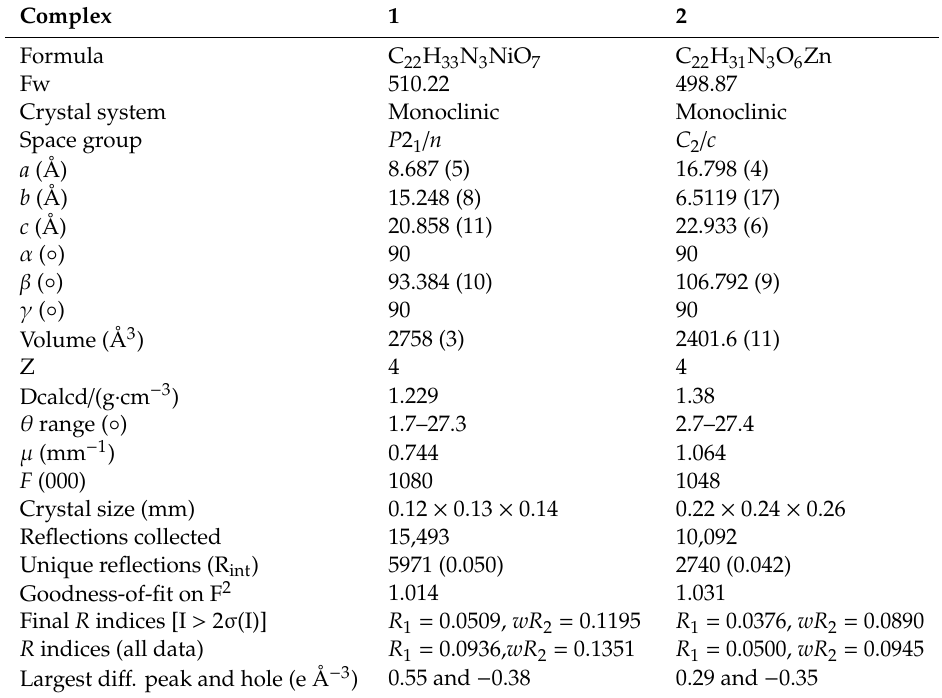
Table 3. Crystallographic data for Complexes 1 and